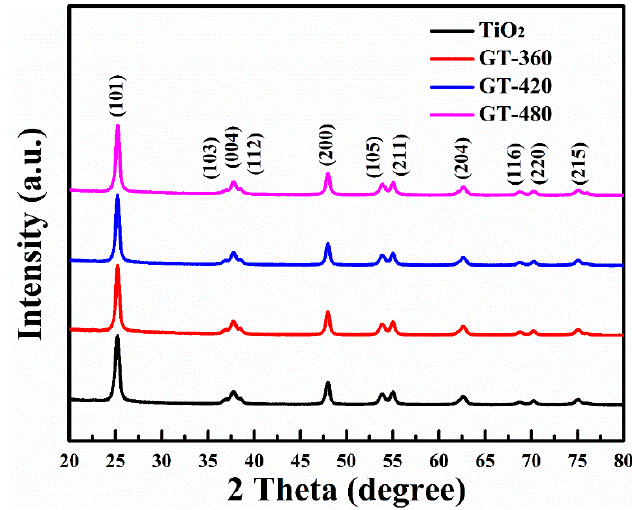
Figure 3. XRD di ff raction patterns of gray TiO 2 − x samples prepared with di ff erent glow discharge Figure 3. XRD diffraction patterns of gray TiO 2 − x samples prepared with different glow discharge powers, and black line refers to anatase TiO 2 powers, and black line refers to anatase TiO 2 .